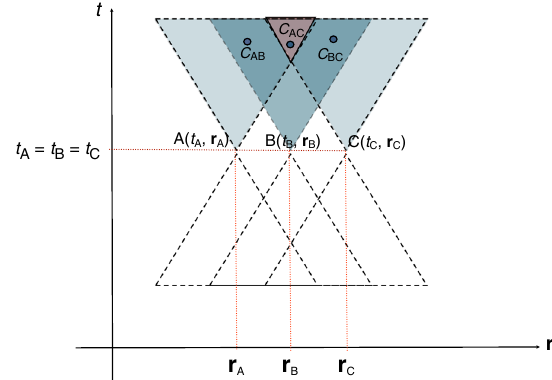
Fig. 2 A particular space – time con fi guration of measurement events in the three-party Bell experiment. The space – time locations of Alice, Bob, and Charlie ’ s measurement events in some inertial reference frame I labeled by axes ( t , r ) are given by ( t A , r A ), ( t B , r B ), and ( t C , r C ), respectively. The correlations between the outputs of Alice and Bob are denoted by a space – time random variable C which manifests itself (is checked by Alice AB and Bob) at a space – time location within the intersection of the future light cones of Alice and Bob. Similarly, the correlations between the outputs of the other pairs of parties are denoted by C and C . The crucial property AC BC of this measurement con fi guration is that the intersection of the future light cones of A and C is contained within the future light cone of B